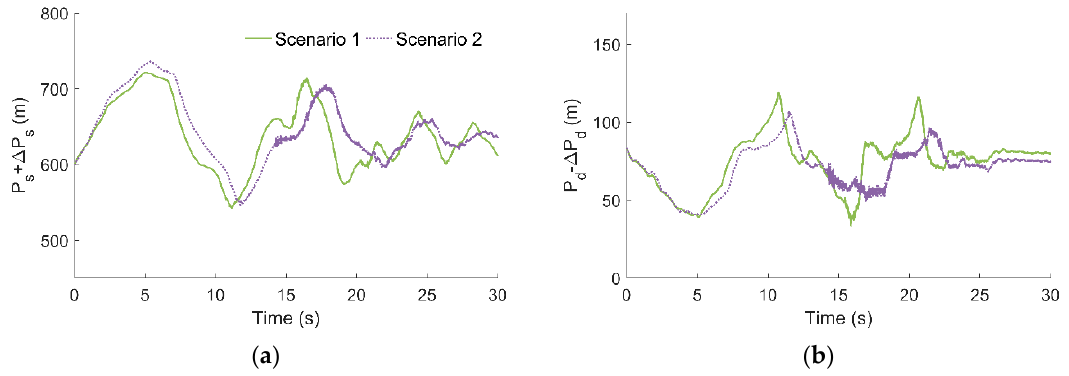
Figure 16. Comparison of dynamic pressure envelopes between the two scenarios in Case 2 at ( a ) the spiral case and ( b ) the draft tube.